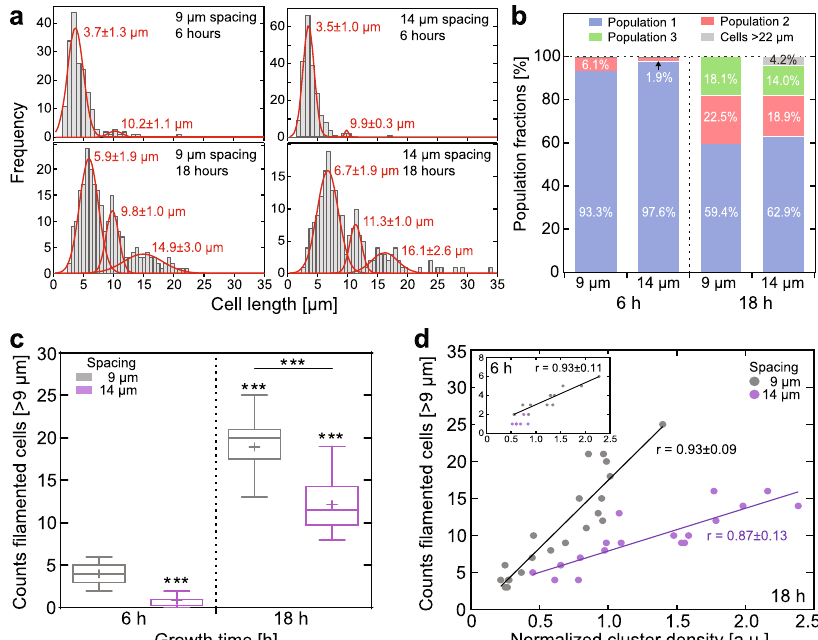
Fig. 3 Bacterial cluster distance-dependent and density-dependent formation of fi lamentous cells. a Cell length distributions for 9 and 14 µm spacing, grown over 6 and 18 h (6 h: 9 µm, N = 183; 14 µm, N = 213; 18 h: 9 µm, N = 249; 14 µm, N = 191). Gaussian fi ts (red) resulting from the applied Gaussian mixture exhibit three distinct cell length populations (see also Supplementary Fig. S3a); the fi t values (±s.d.) are denoted within the plot. b Fractions (integral of Gaussian fi ts from ( a )) of the different populations observed in all tested conditions. c Number of fi lamentous cells detected in the proximity of-or emanating from-bacterial clusters for all tested conditions (from N = 9 fl uorescence images each). Legend for box and whisker plot: the center line denotes the median value (50th percentile), the cross the mean average, the bounds of the box contain the 25th to 75th percentiles, the whiskers mark the 1.5 interquartile range. d Number of fi lamentous cells in dependency of cluster density after 18 h growth (inset for 6 h growth), calculated from the bacterial cluster fl uorescence intensity and normalized to the number of fi lamentous cells for all tested conditions. Lines represent linear fi ts and the corresponding Pearson correlation coef fi cients ( r ) are denoted for each fi t. Asterisks indicate statistical signi fi cance (*** p < 0.001), resulting from two-tailed, unpaired t -tests. See also Supplementary Fig.